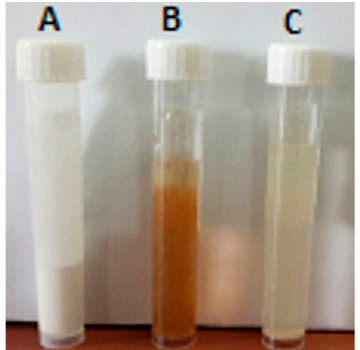
Fig. 1. Shows the comparison between three